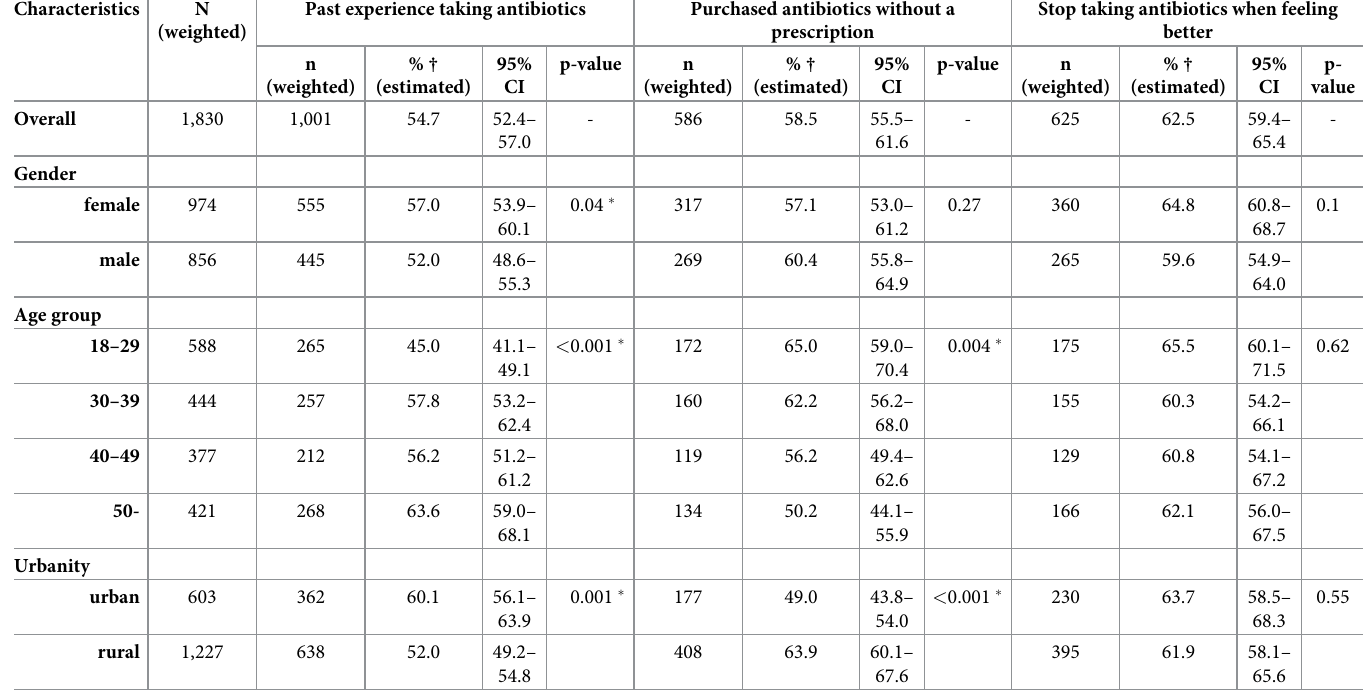
Table 4. Antibiotic use practices (N =